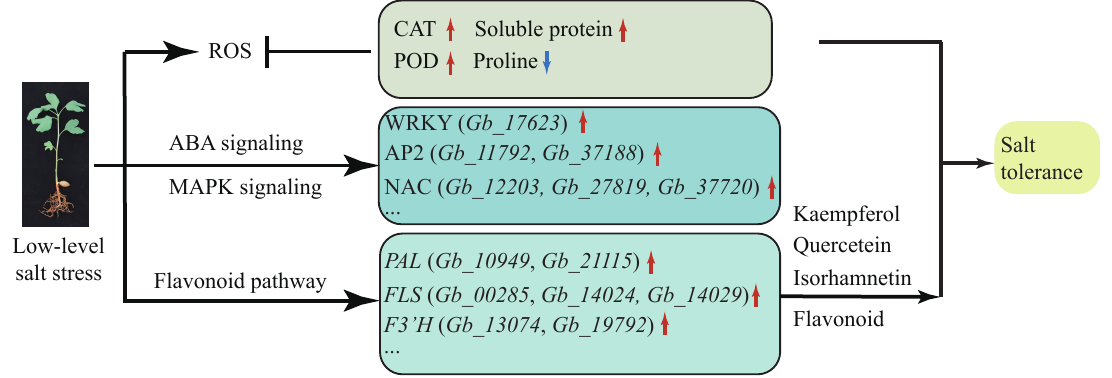
Figure 7. Model diagram of signal pathway and metabolic pathway changes in G. biloba seedings under low-level salt